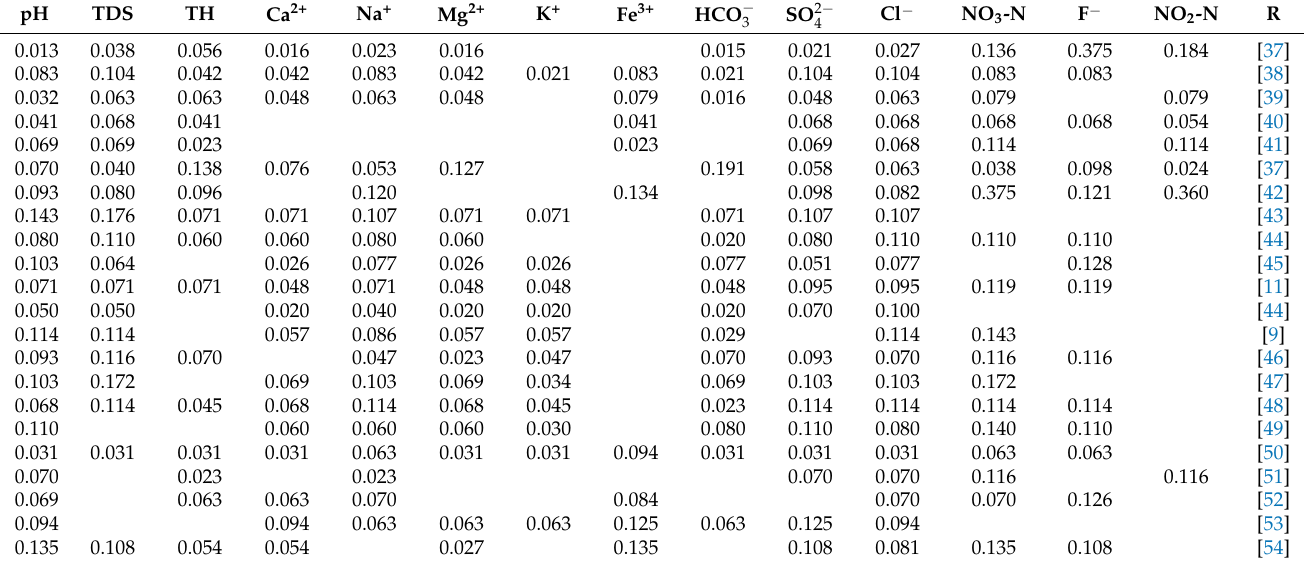
Table 1. The weights of water quality evaluation parameters were collected through different